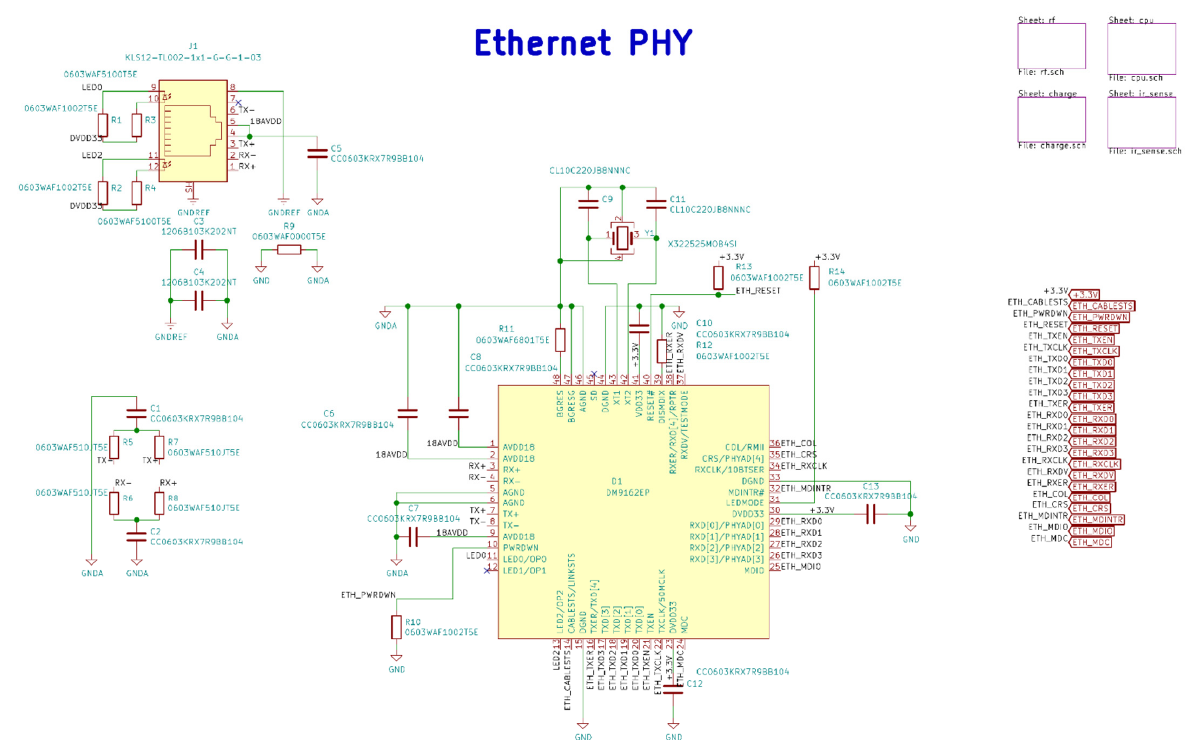
Figure A2. Base station Ethernet PHY electrical schematic diagrams.